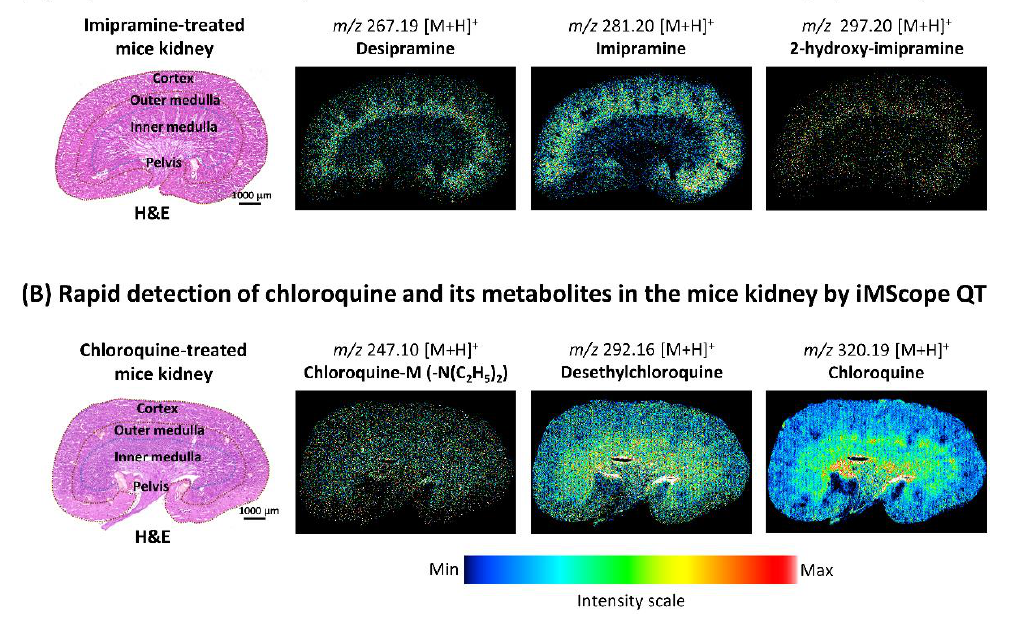
Figure 5. Rapid localization of imipramine, chloroquine, and their metabolites in the kidneys of treated mice with higher spatial resolution applying iMScope QT. ( A ) Distribution of imipramine and its metabolites in the mice kidney using higher data acquisition speed (32 pixels/s). ( B ) Distribution of chloroquine and its metabolites in the mice kidney using higher data acquisition speed (32 pixels/s). Here, the spatial resolution was 25 µm × 25 µm (X,Y).